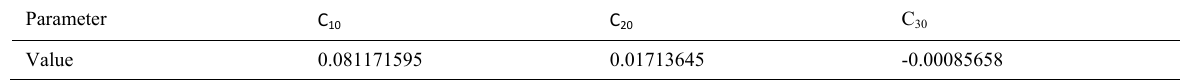
Table 5: Parameters for the material model of Yeoh for the structural silicone under